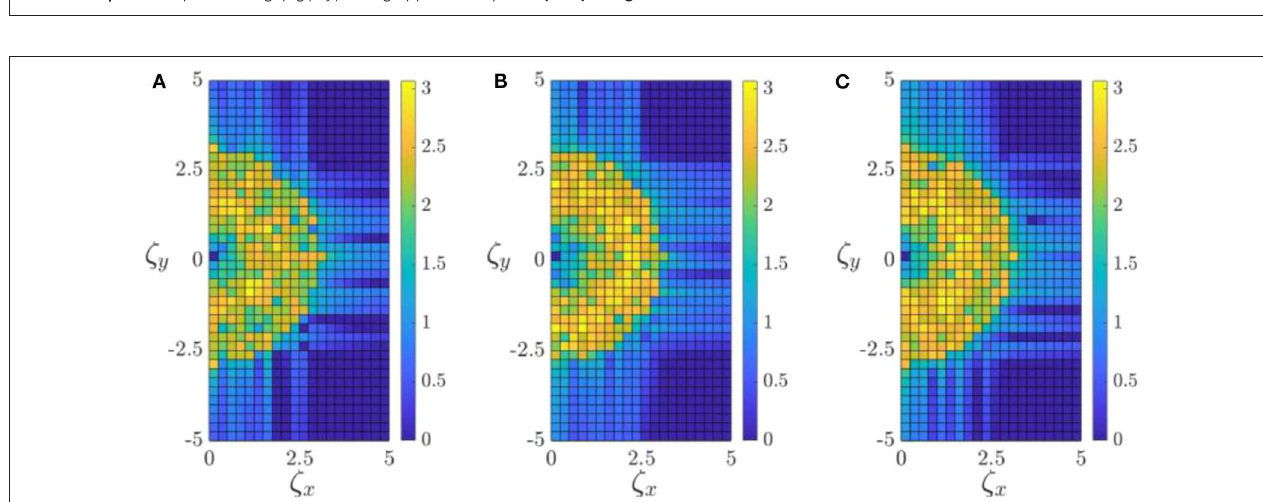
FIGURE 4 | Contour plot of the gap g ( x , y ) during approach at points (A–C) in Figure 3 .